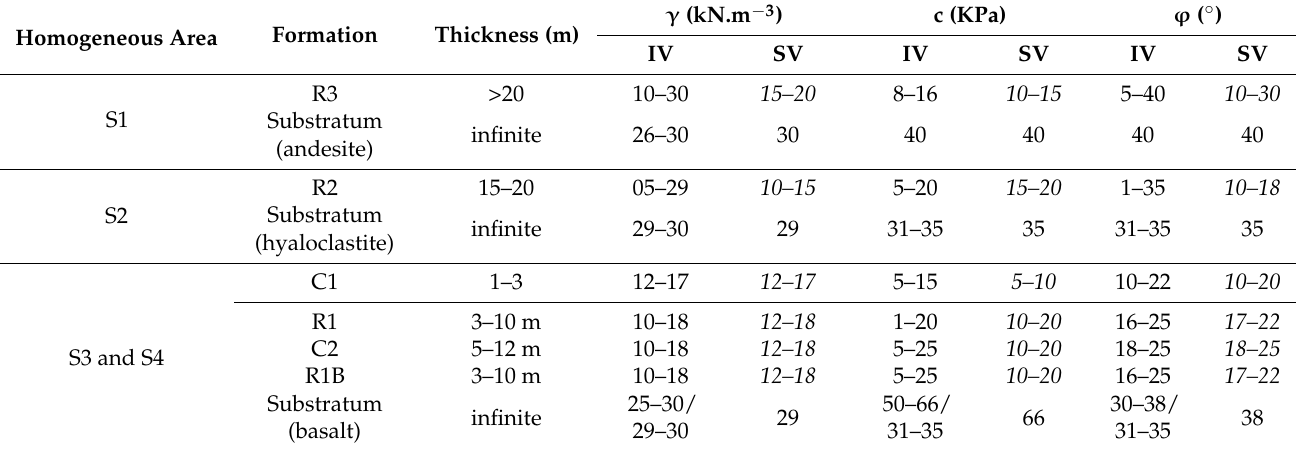
Table 6. Geotechnical values selected after sensitivity analysis for the Morne-Figue area. IV = initial values; SV = selected values; γ = bulk unit weight; c = cohesion; ϕ = angle of friction; italic values are introduced as triangular probability distributions in ALICE ®